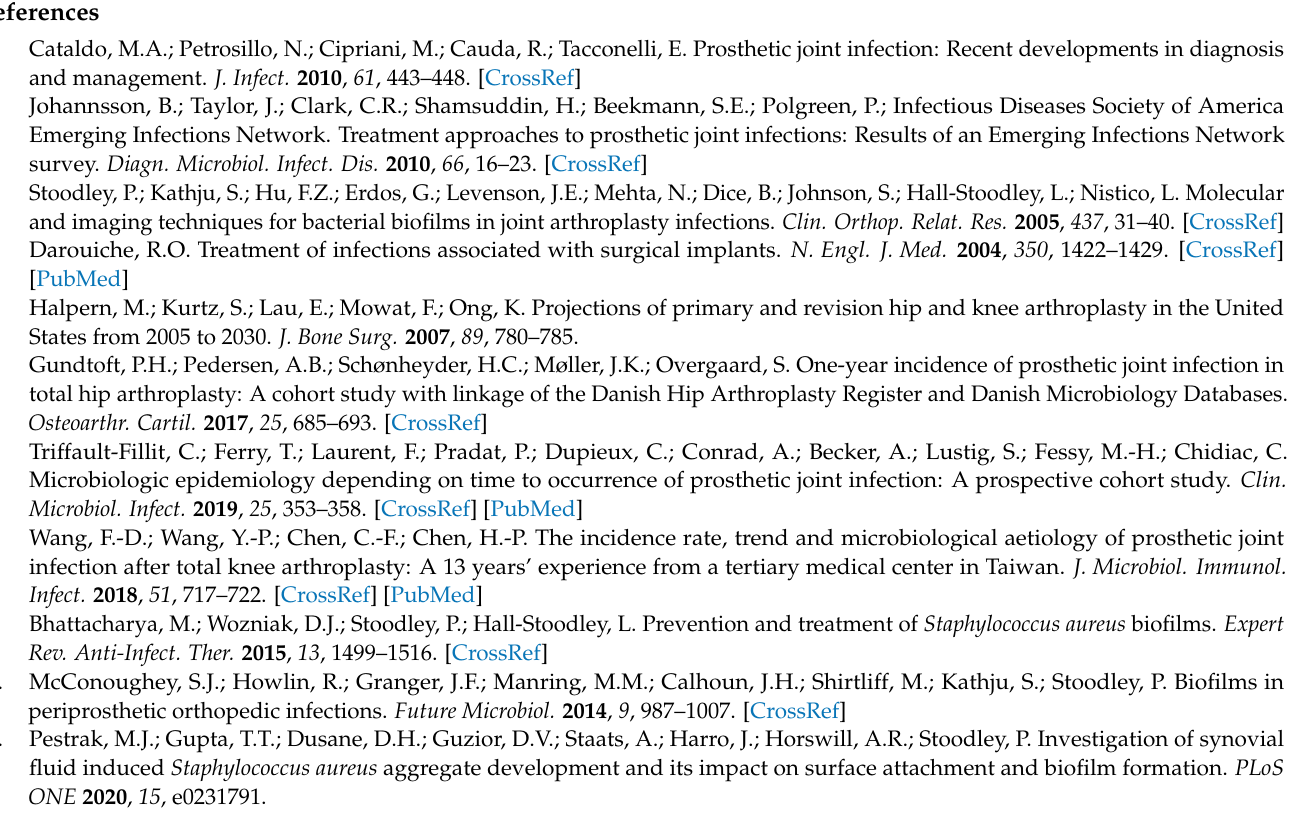
corresponding to Figure S2, Figure S4: Unprocessed Raman spectra of a stainless-steel coupon after cleaning according to mentioned protocol (black) and biofilm on a cleaned coupon (red). The ab- sence of any signature peaks in the cleaned coupon suggests that there is absence of any organic or soap-like